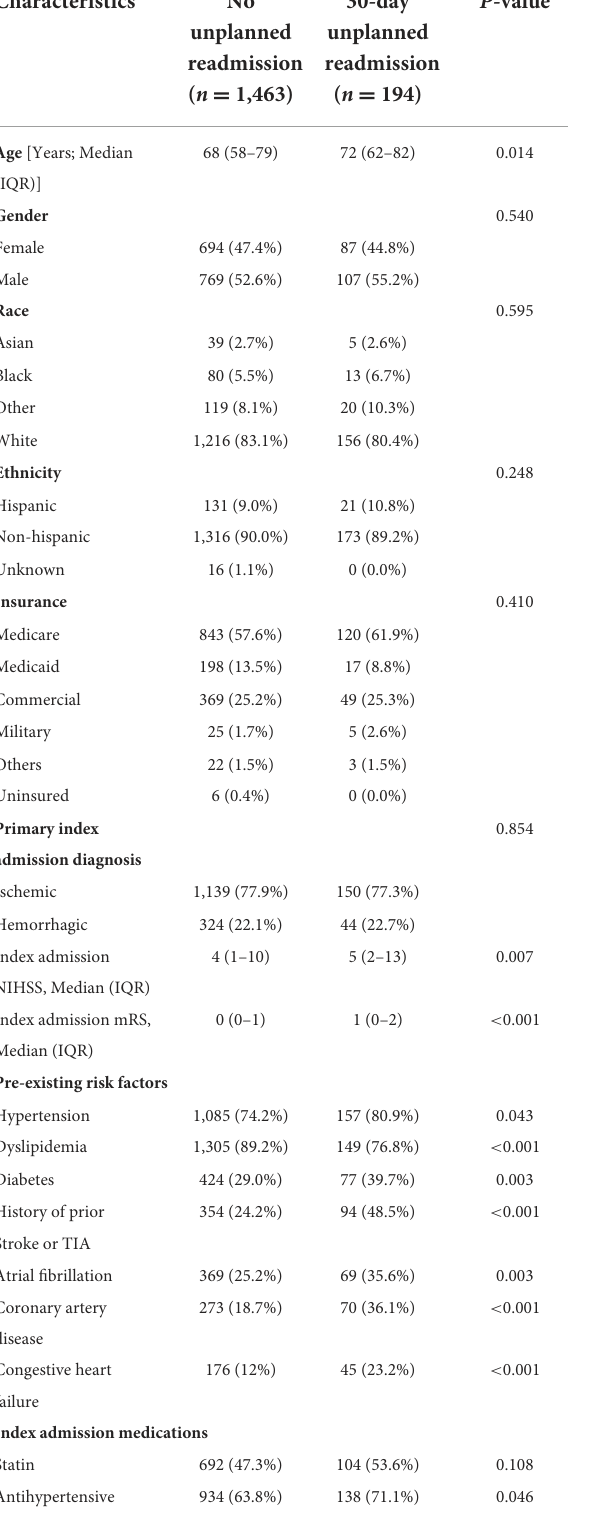
TABLE 1 Patient characteristics stratified by absence vs. presence of unplanned 30-day readmission.